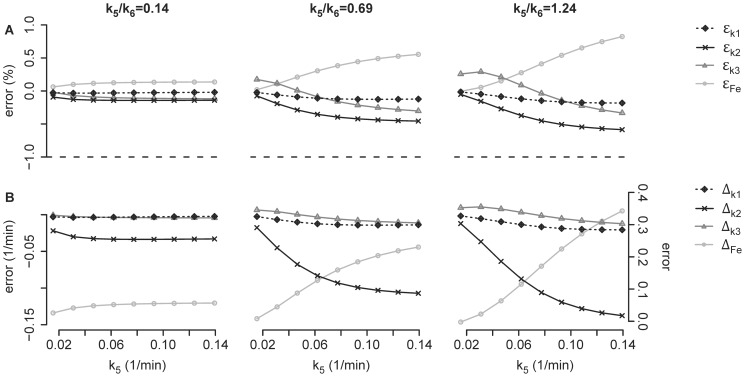
Estimation Errors as a Function of k5.(A) Relative errors of k1 (εk1 = (k1S-k1F)/k1F ·100), k2 (εk2 = (k2S-k2F)/k2F ·100), k3 (εk3S = (k3S-k3F)/k3F·100) and Fe (εFe = (Fe-Fei)/Fei·100) versus k5 at a k5/k6 ratio of 0.14, 0.69 and of 1.24; (B) absolute errors of k1 (Δk1 = k1S-k1F), k2 (Δk2 = k2S-k2F), k3 (Δk3S = k3S-k3F) and Fe (ΔFe = Fe-Fei) versus k5 at a k5/k6 ratio of 0.14, 0.69 and of 1.24.